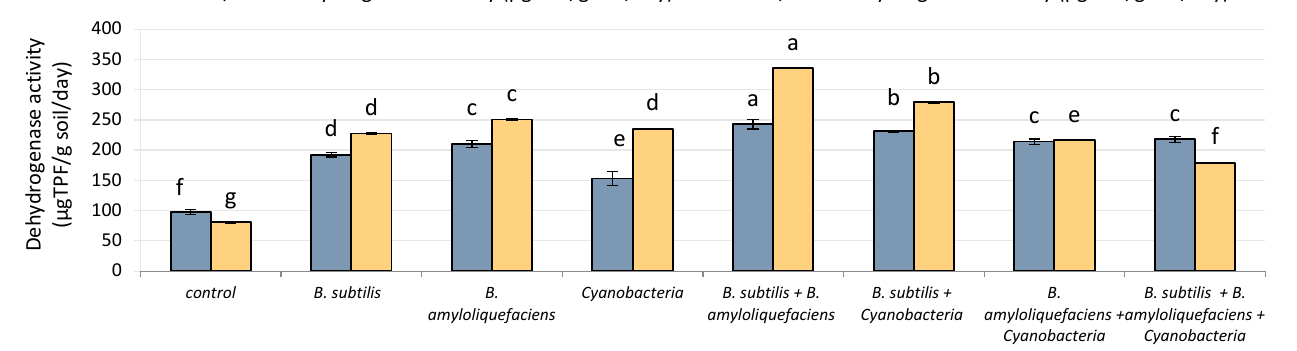
Figure 1. The effect of inoculation with two PGPR strains ( B. subtilis and B. amyloliquefaciens ) and cyanobacteria on the dehydrogenase (DHA) activity ( μ g TPF/g dry soil/day) in the rhizosphere soil of tomato plants in two seasons (2020/2021) and (2021/2022). Different letters indicate significant differences between treatments (ANOVA, LSD, p < 0.05). Error bars represent standard error of the mean.